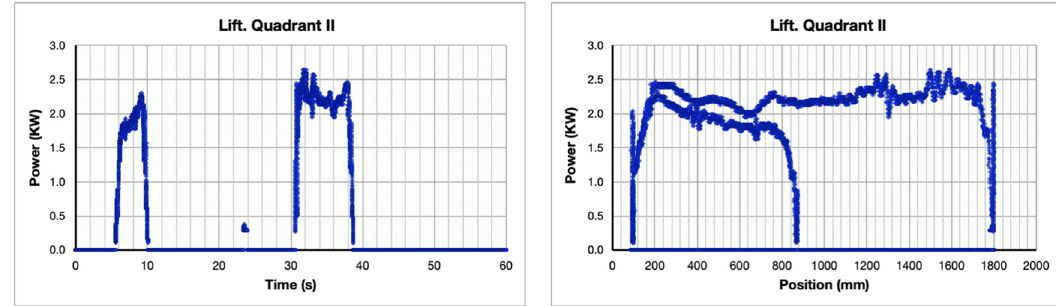
Figure 13. Recoverable power vs. time ( left ) and position ( right ) for the lift actuator in quadrant II.